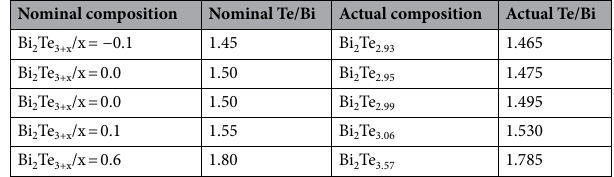
Table 2. The compositions and Te/Bi ratio of the Bi–Te thin films fabricated without a pre-deposited Cr layer at high substrate temperature.